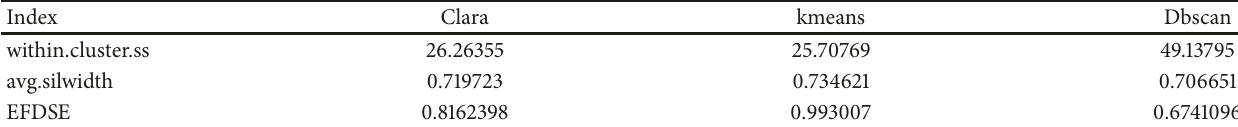
Table 4: The index of stability Clara Kmeans